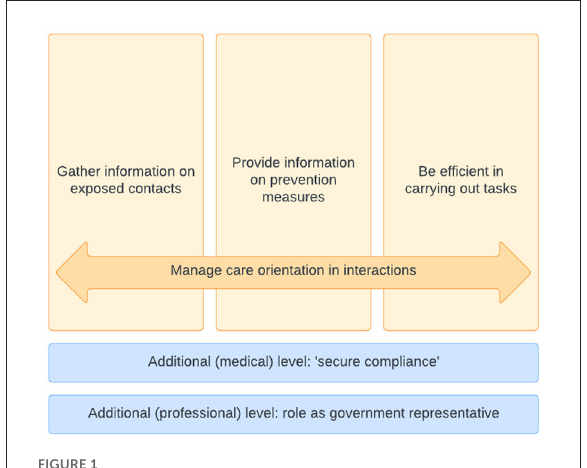
FIGURE1 Functions of the contact tracing call, as identified through systematic interactional